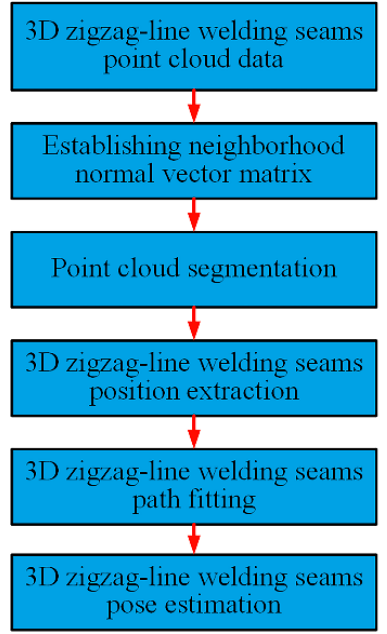
Figure 3. 3D zigzag-line welding seams pose information online fast extraction process.